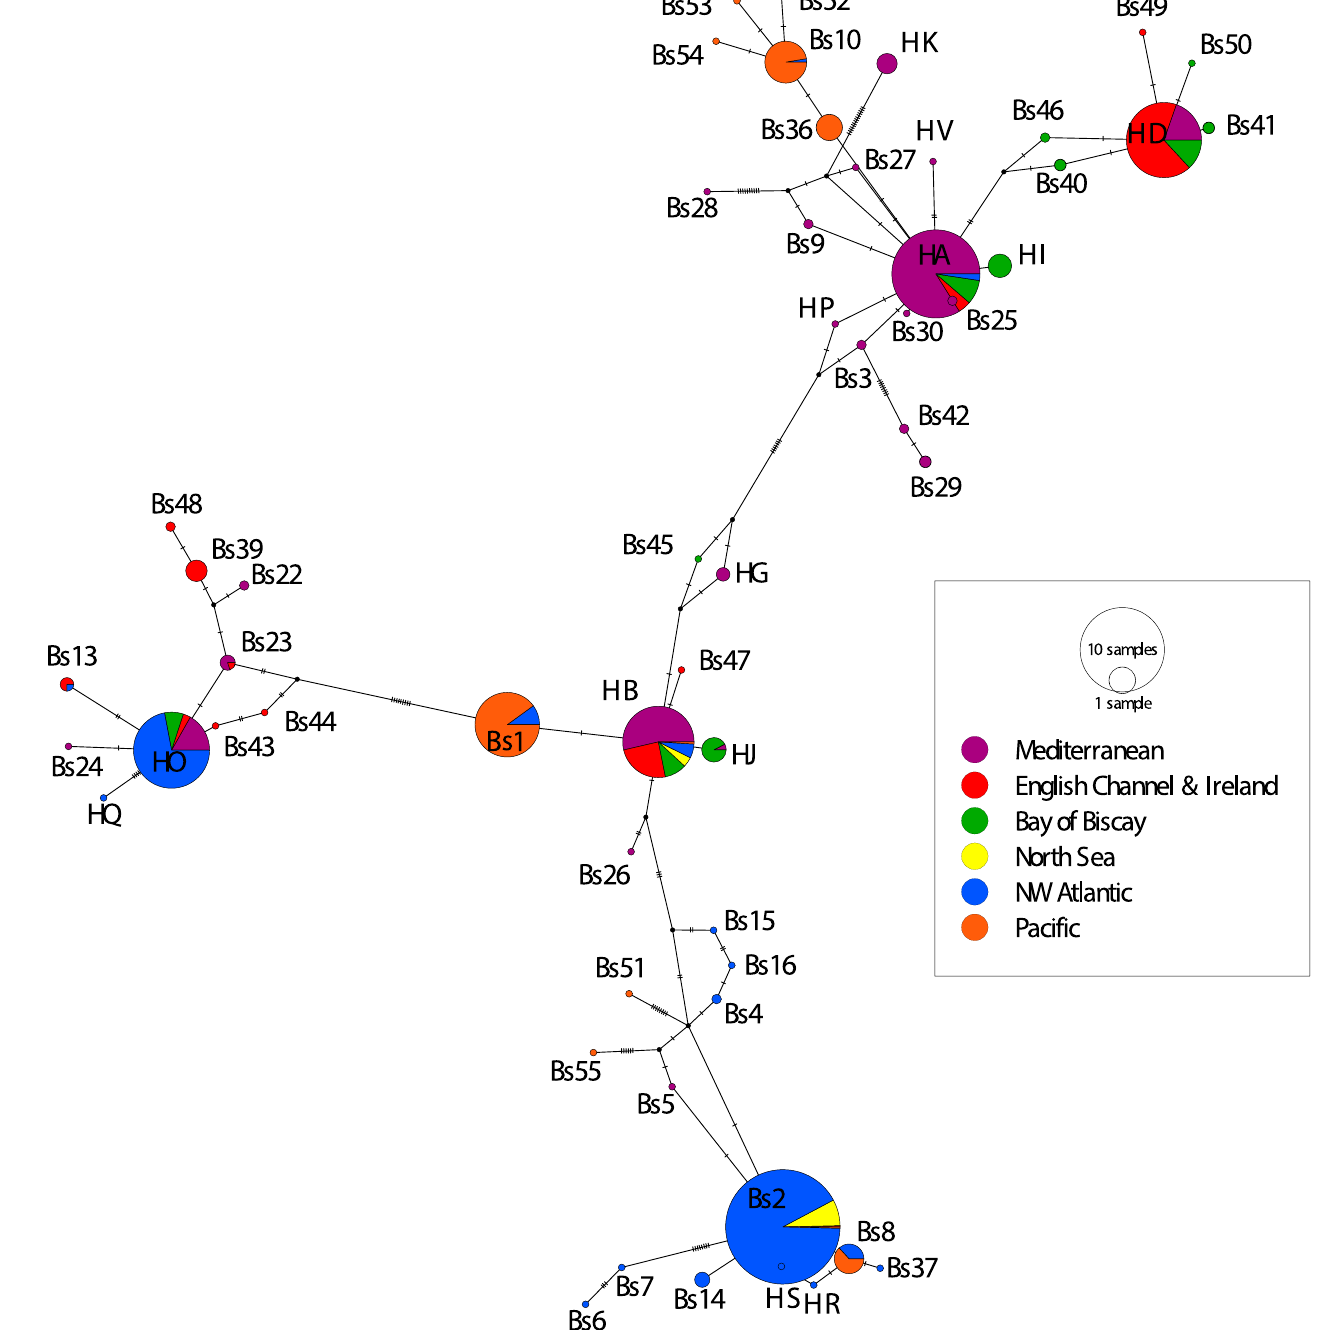
Fig 1. Median joining haplotype network of all Clade A populations. Populationsare groupedinto six geographic regions: Mediterranean, English Channel+ Ireland, Bay of Biscay, North Sea, northwestern (NW) Atlantic,